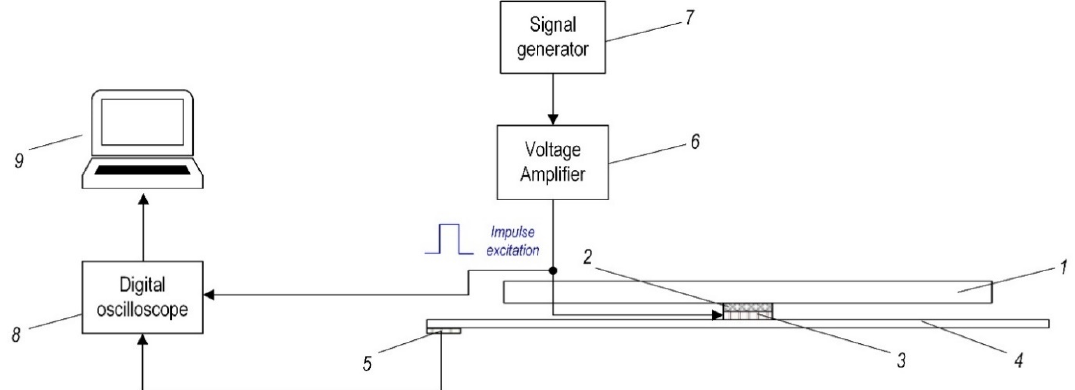
Figure 9. Scheme of experimental set-up during the mechanical impact force investigations: 1—aluminum base, 2—soft isolation layer, 3—piezoelectric transducer–actuator (for excitation), 4—composite plate, 5—piezoelectric transducer–sensor, 6—voltage amplifier EPA 104, 7—signal generator Agilent 33220A, 8—digital oscilloscope PicoScope 6407, 9–PC.